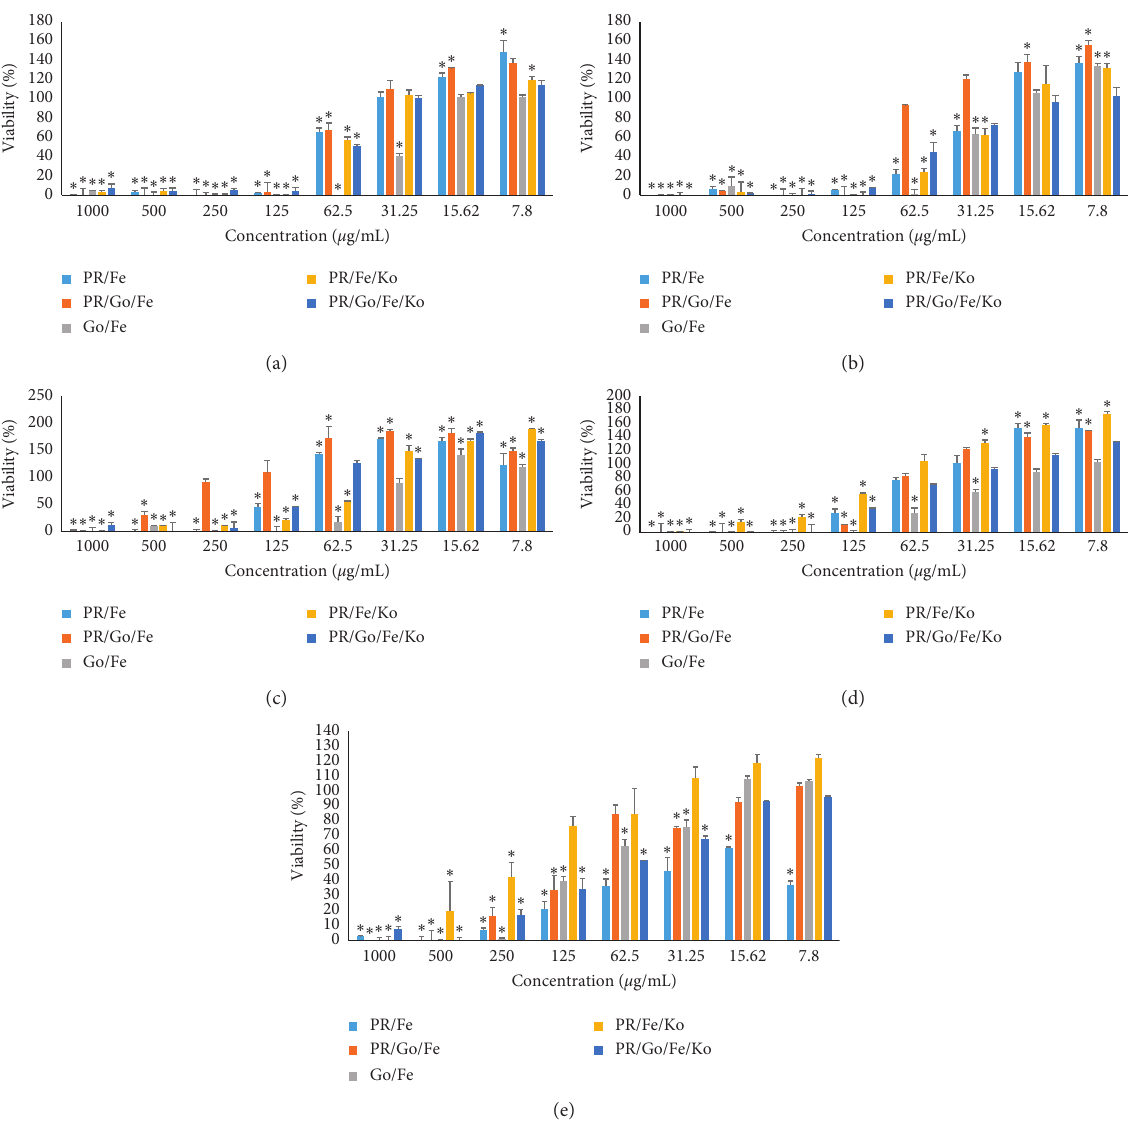
Figure 5: The effects of nanocomposite on the antibacterial of different samples. (a) Effect of nanoparticles on E. coli . (b) Effect of nanoparticles on Pseudomonas aeruginosa . (c) Effect of nanoparticles on Staphylococcus aureus . (d) Effect of nanoparticles on Enterococcus faecalis . (e) Effect of nanoparticles on Candida albicans